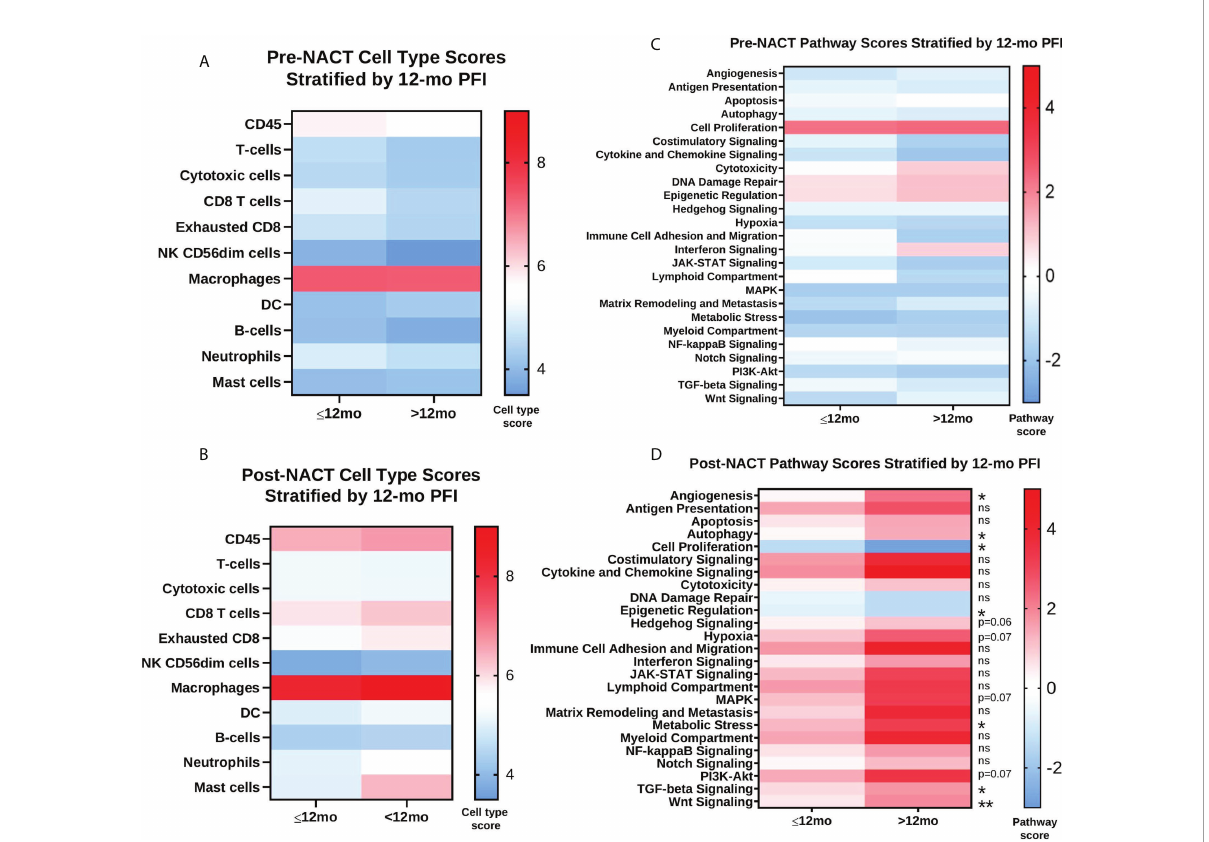
FIGURE 9 Post-NACT pathway scores are associated with platinum free interval (PFI) greater than 12 months. (A, B) Pre-NACT and post-NACT median cell type scores strati fi ed by ≤ 12 mo PFI and >12 mo PFI. (C, D) Pre-NACT and post-NACT median pathway scores strati fi ed by ≤ 12 mo PFI and >12 mo PFI. Signi fi cance determined by unpaired Mann-Whitney test. *p<0.05; **p<0.005; ns = not signi fi cant. Scores do not indicate abundance of one cell type/pathway relative to